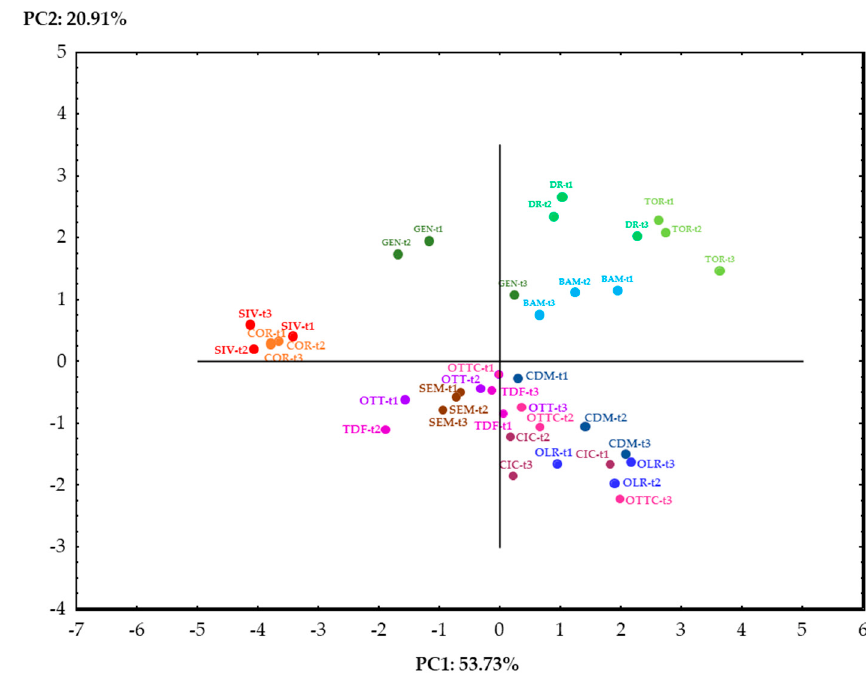
Figure 5. Projections of the cases on a factor